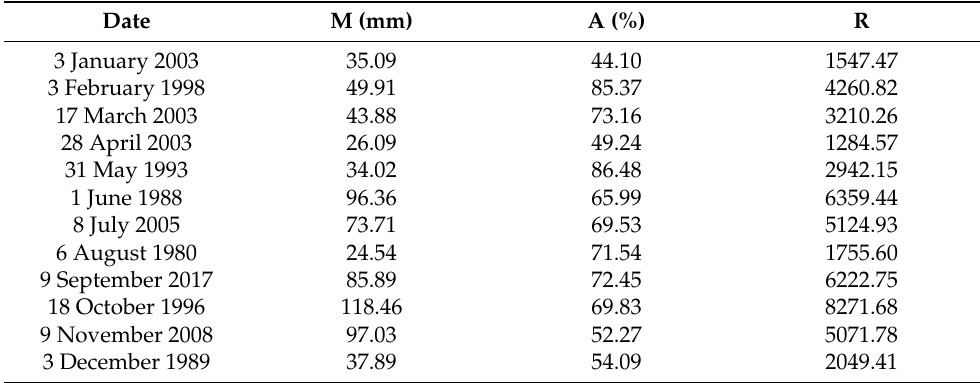
Table 1. Top monthly extreme precipitation events in the period from 1980 to